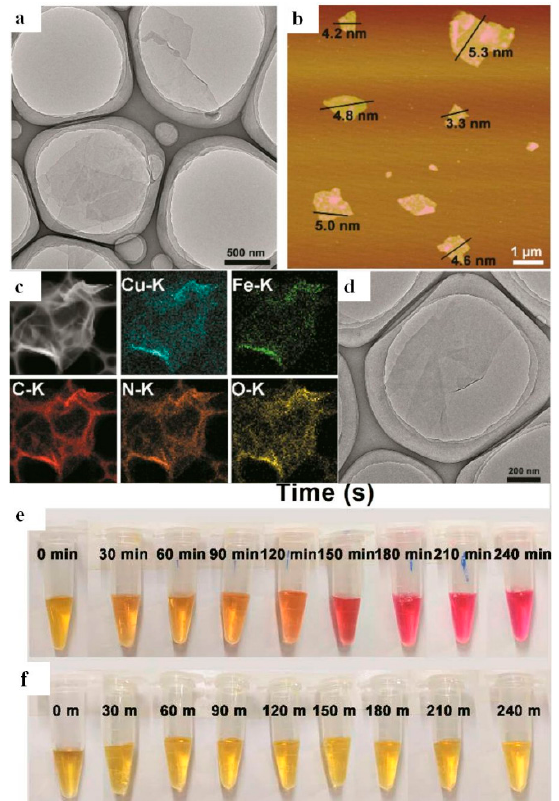
Figure 8. TEM micrograph of Cu-TCPP(Fe) 2D MOF nanosheets ( a ). AFM image of Cu-TCPP(Fe) 2D MOF nanosheets and their thickness distribution ( b ). Darkfield TEM image of typical Cu-TCPP(Fe) 2D MOF nanosheets and the corresponding TEM element mappings ( c ). TEM image of Cu-TCPP(Fe) 2D MOF/GOx ( d ). Time-dependent color changes of TMB reaction solutions catalyzed by the Cu-TCPP(Fe) 2D MOF / GOx every 30 min in pH 7.4 PBS bu ff er (0–240 min, e ) or pH 7.4 PBS bu ff er (0–240 m, f